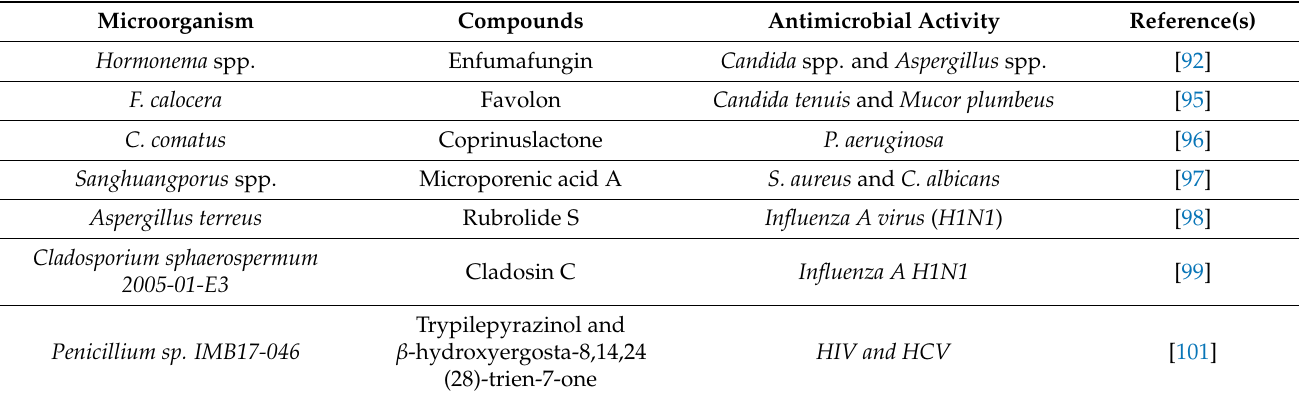
Table 4. Antimicrobial activity of chemical compounds from